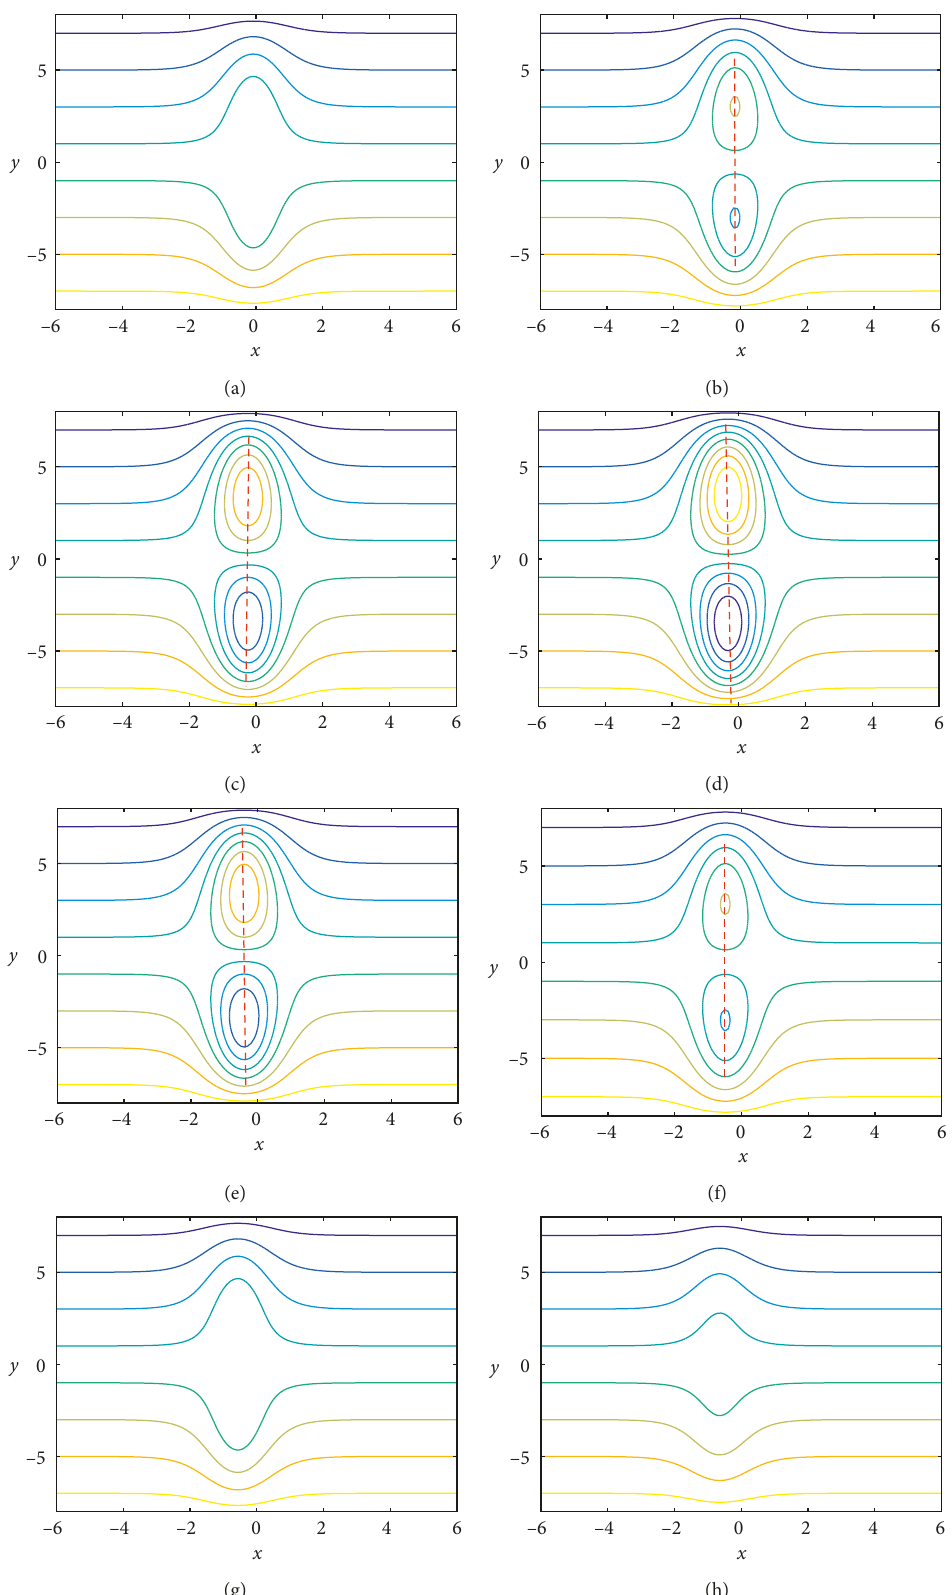
Figure 2: A dipole blocking life cycle from the theoretical solution of Equation (114) in [13]. (a) Day 1, (b) day 2, (c) day 3, (d) day 4, (e) day 5, (f) day 6, (g) day 7, and (h) day